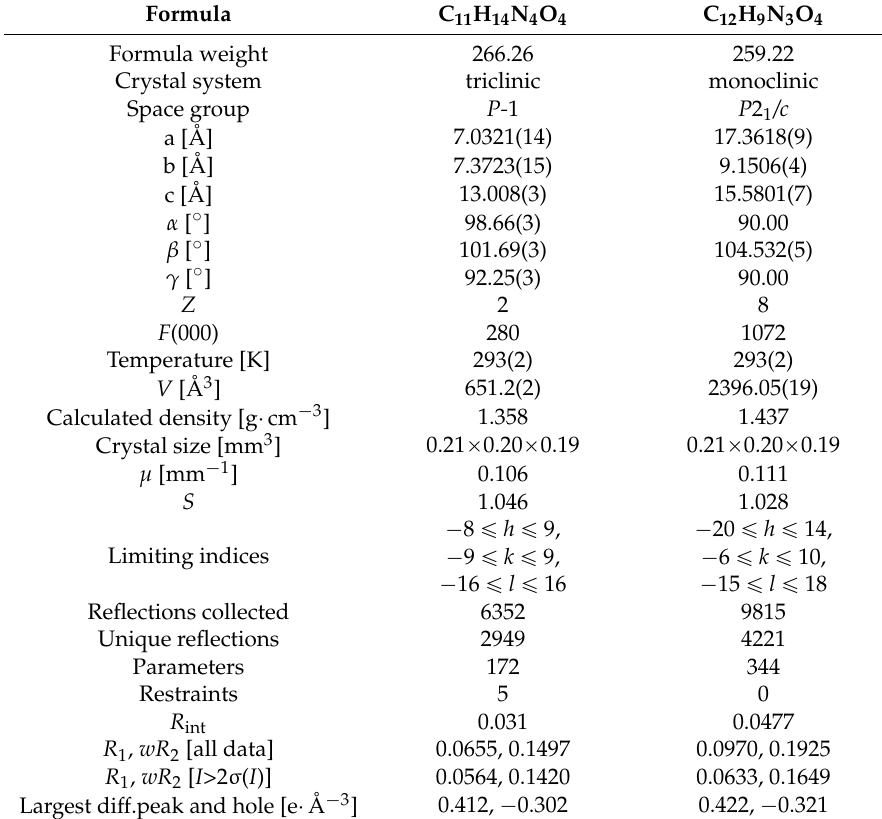
Table 1. Crystal data for 1 and 2 .